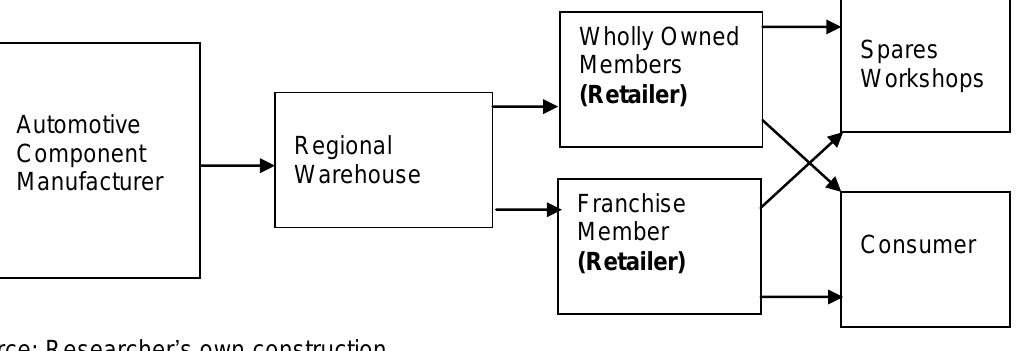
Figure 2(b): Component distribution channel – the Supergroup / Autozone